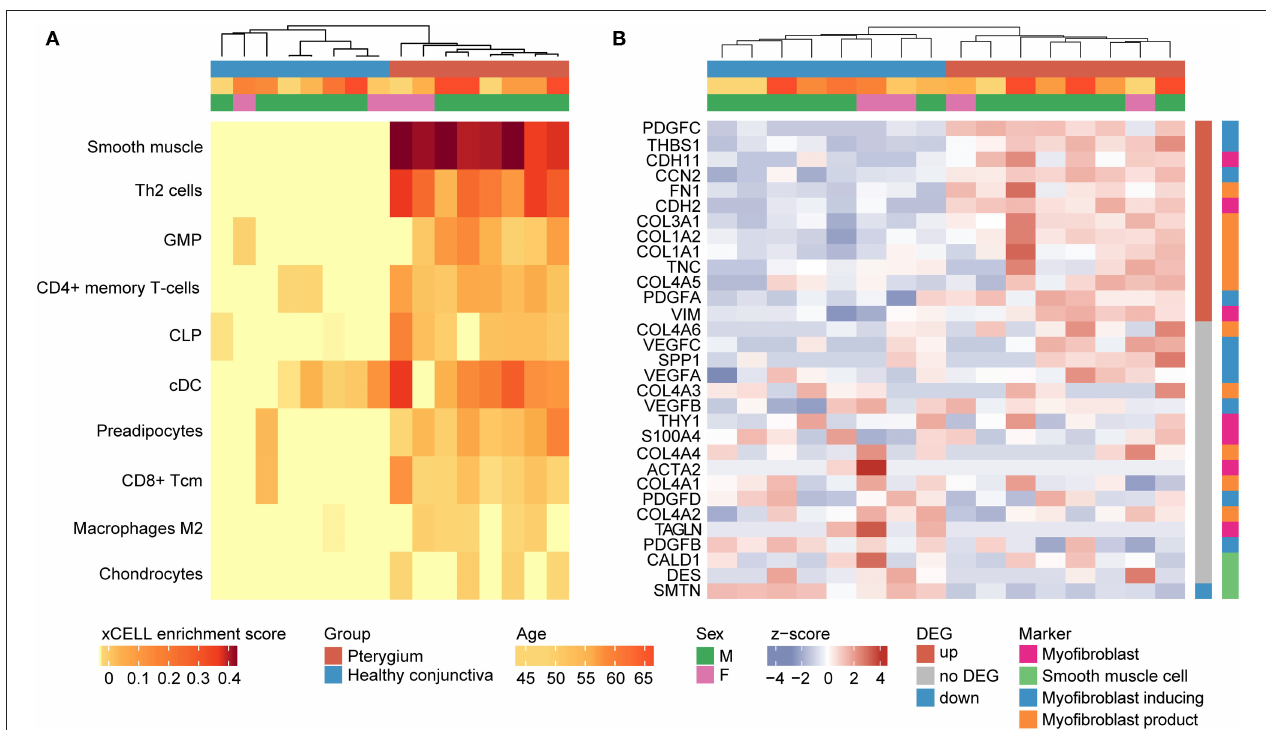
FIGURE 2 | Cellular microenvironment of pterygia (A) cell type enrichment analysis using xCell. The tool uses gene expression profiles of 64 immune and stromal cell types to calculate cell type enrichment scores. Heatmap illustrating xCell enrichment scores of 10 of the 64 cell types which were significantly enriched in pterygia compared to healthy conjunctiva ( p < 0.05, Mann-Whitney U -test). Each row represents one cell type, each column represents one sample. Rows are ordered according to the fold change of mean enrichment scores. Columns are clustered according to similarities in xCell enrichment scores (see dendrogram). Basic demographic and clinical data are shown above. Th2, type 2 T-helper cells; GMP, granulocyte-monocyte progenitor; CLP, common lymphoid progenitor; cDC, classical DC; Tcm, central memory T cell. (B) Since according to (A) smooth muscle cells seemed to be the dominant cell type in pterygia, the expression of known markers of smooth muscle cells as well as of myofibroblasts was subsequently analyzed (B) revealing a myofibroblast-specific expression